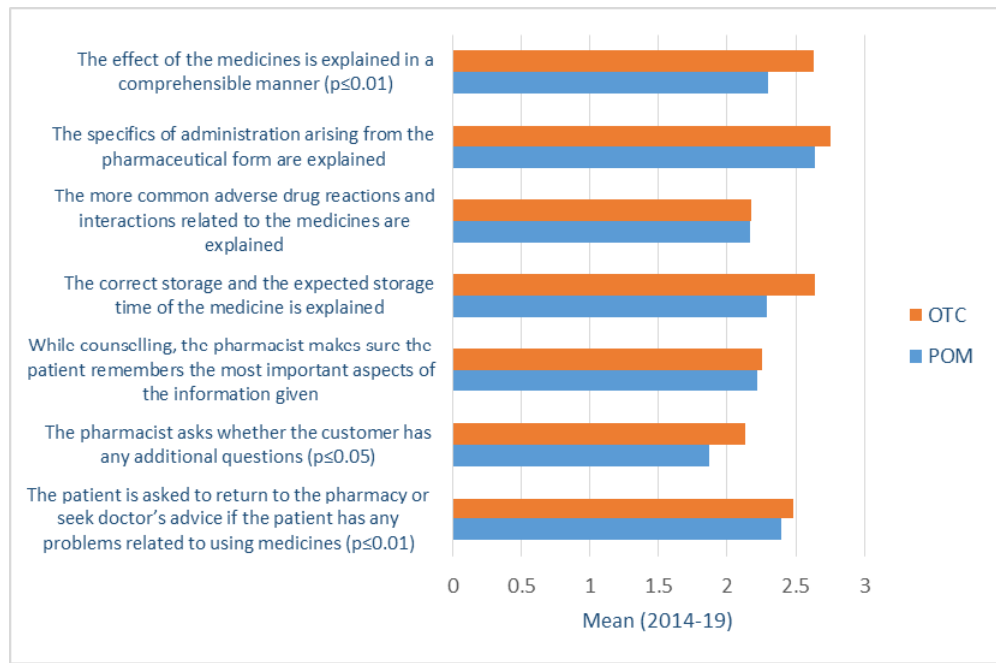
Figure 2. Patient counselling about OTCs and POMs based on the evaluation of the Community Pharmacy Service Quality Guideline (four-point scale) in 2014-19.